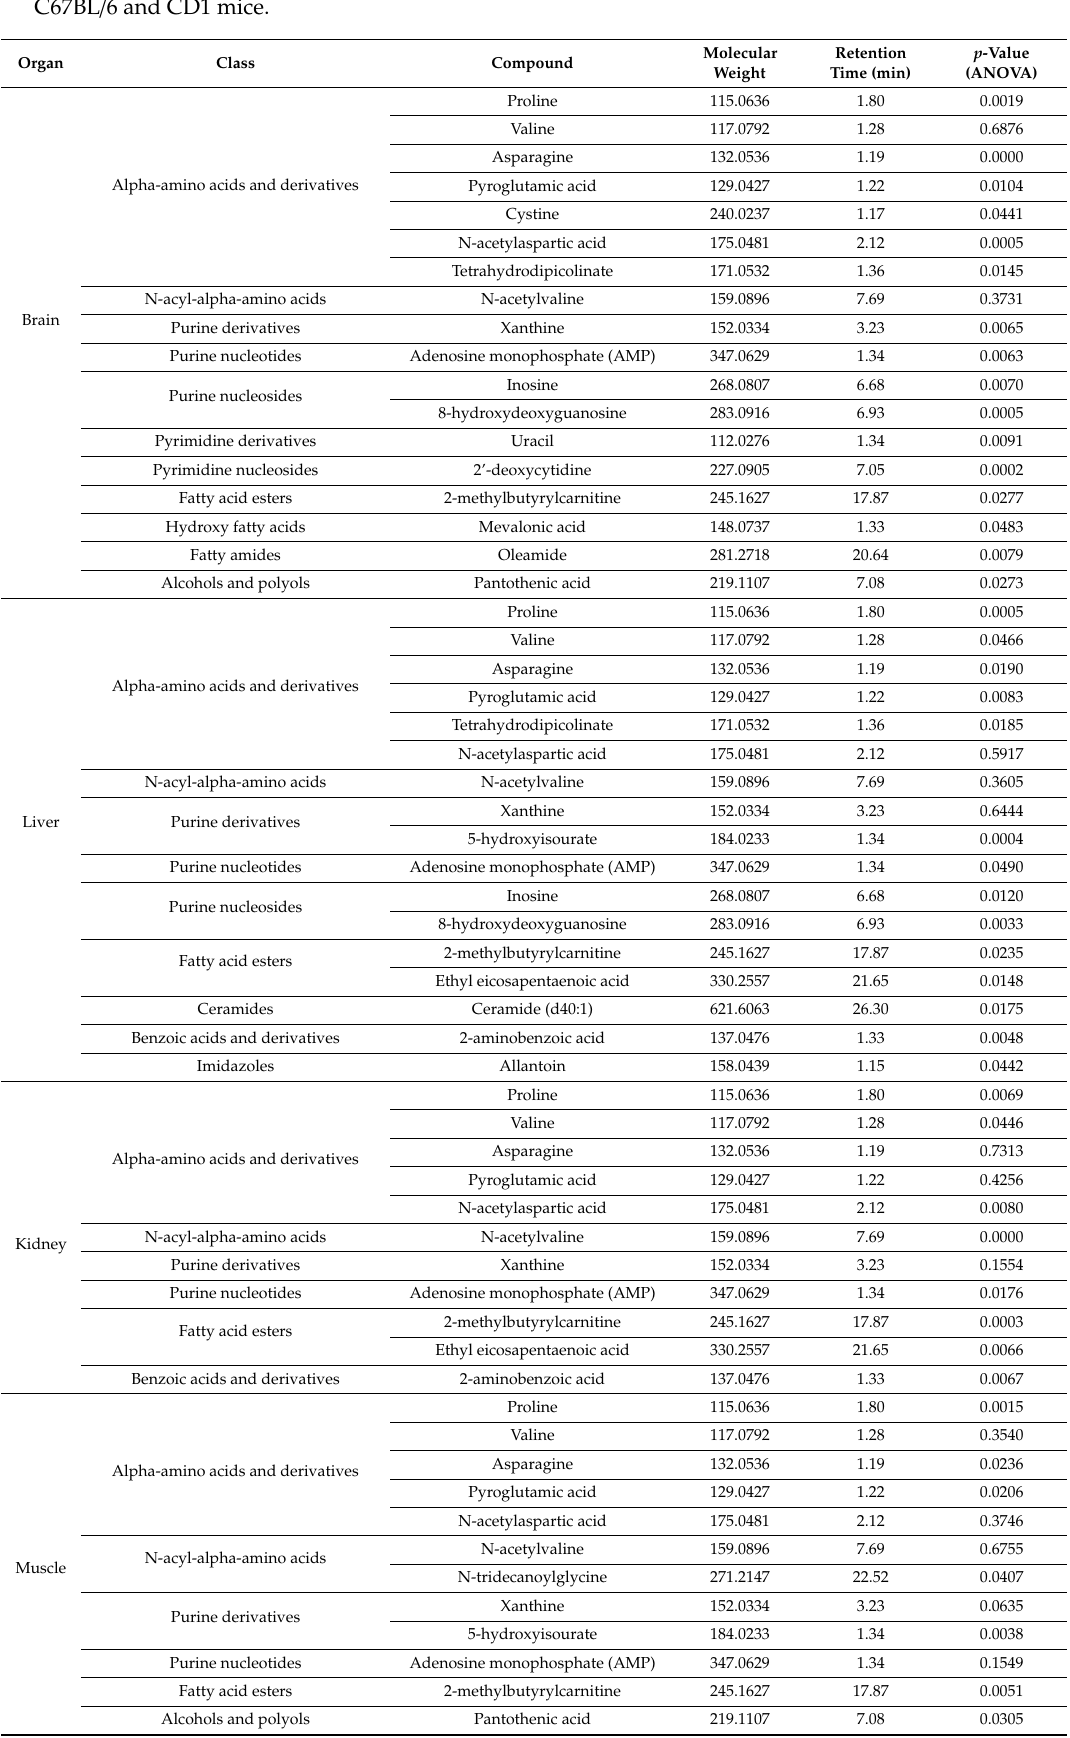
Table 1. Chemical taxonomy of selected annotated features present in examined tissues of BALB / c, C67BL / 6 and CD1